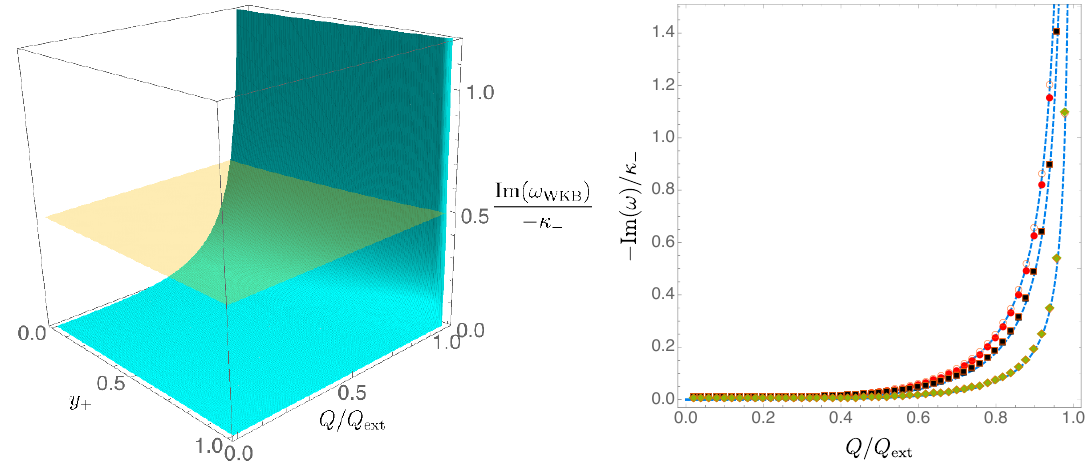
Figure 2 . Left panel: photon sphere quasinormal modes in the geometric optics/WKB approx- imation as a function of charge ratio Q=Q ext and y + = r + =r c for n = 0. The yellow plane is (cid:0) Im( ! ) =(cid:20) (cid:0) = 1 = 2. Right panel: WKB prediction for (cid:0) Im( ! ) =(cid:20) (cid:0) compared with numerical results for (cid:8) (cid:0) photon sphere modes. The curves are for y + = 0 : 1 (top), y + = 0 : 4 (middle) and y + = 0 : 8 (bottom). The dashed blue lines are the n = 0 geometric optics/WKB prediction (cid:0) Im( ! WKB ) =(cid:20) (cid:0) . The red disks, black (cid:12)lled squares, green (cid:12)lled diamonds are the numerical results for ‘ = 2 ; n = 0. The empty orange marks (circles, squares, diamonds) are the numerical results for ‘ = 10 ; n =